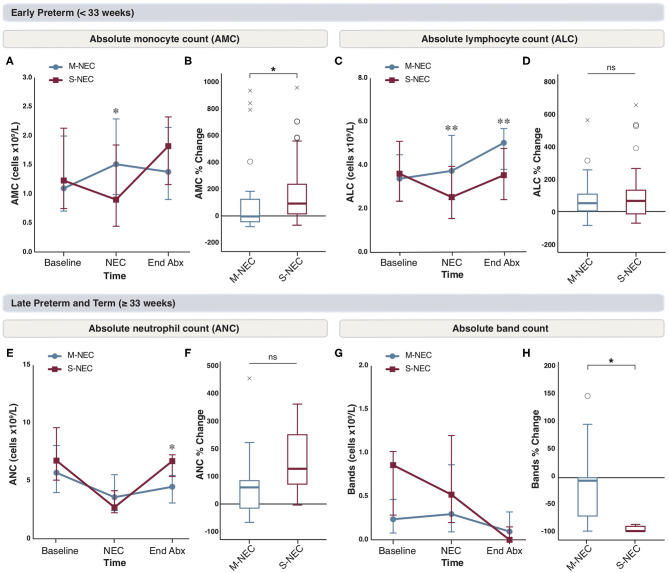
Changes in peripheral cell counts in infants <33 weeks (A–D) and ≥33 weeks (E–H) at the end of antibiotic treatment. Median absolute levels of monocytes (A), lymphocytes (C), neutrophils (E), and bands (G) are plotted at baseline, NEC diagnosis, and the end of the antibiotic course (End Abx). Tukey boxplots for percent changes in monocytes (B), lymphocytes (D), neutrophils (F), and bands (H) at end of antibiotics compared with NEC diagnosis. Bars represent 25 and 75% percentiles (A,C,E,G) or 1.5× the IQR (B,D,F,H). *Significance for absolute cell count; *p < 0.05, **p < 0.01. *Significance for percent change; *p < 0.05. °Indicates outliers (>1.5 × IQR) and xindicates extreme outliers (>3 × IQR).